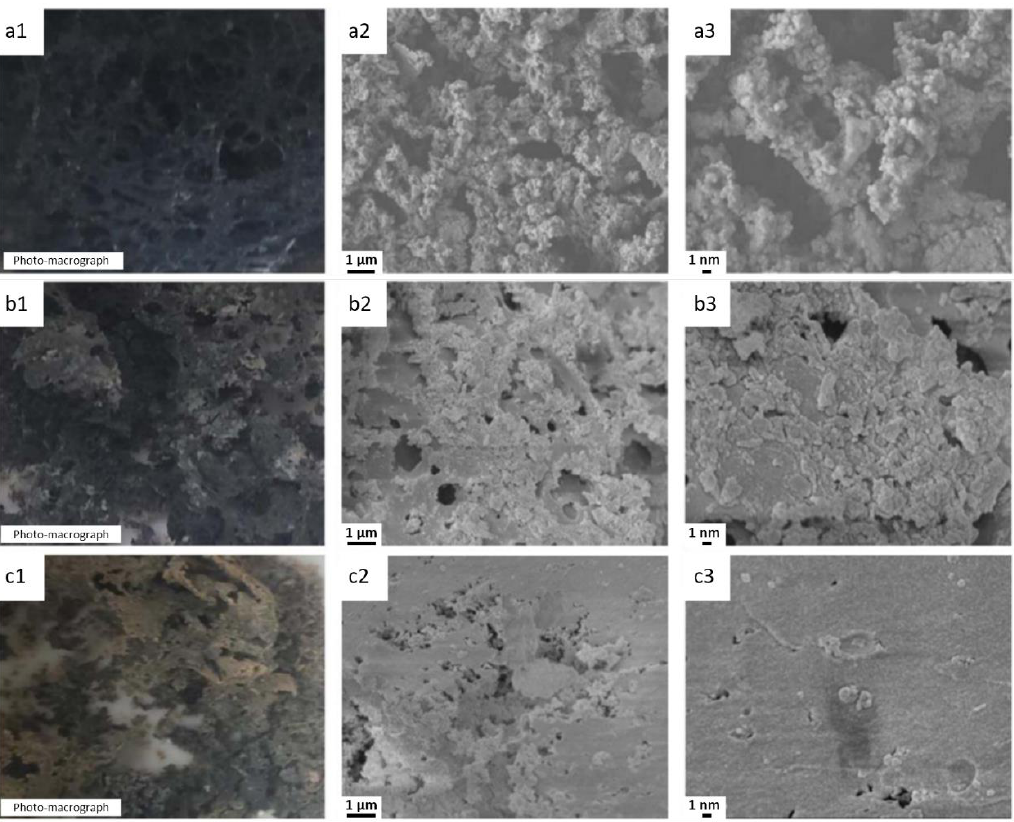
Figure 37. Surface morphology analysis of carbide composite materials: ( a1 – a3 ) Pure poly(butylene terephthalate) (PBT) and composites with ( b1 – b3 ) 1.5 and ( c1 – c3 ) 5 wt% nano-Sb 2 O 3 [247]. Reproduced with permission from Ref. [248]. Copyright 2018, Taylor & Francis.